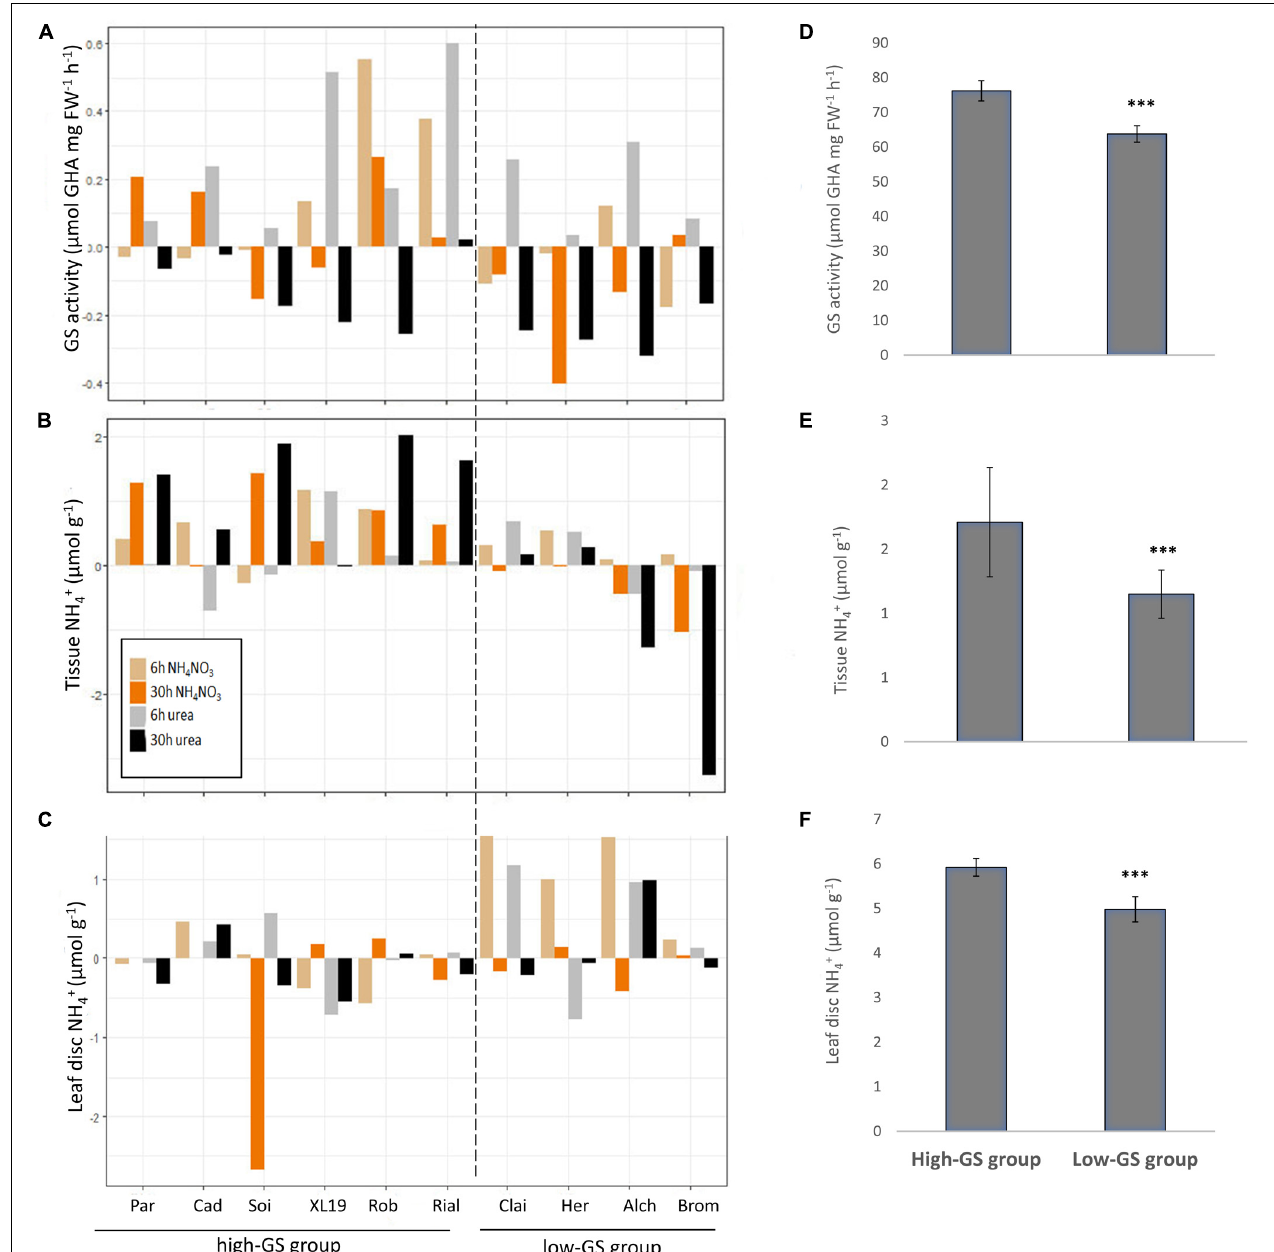
FIGURE 4 | Differential response of ten wheat genotypes to N fertilisers. Ten elite United Kingdom wheat genotypes were treated with the equivalent of 250 kg N ha − 1 applied either as NH 4 NO 3 or urea and the response of GS activity (A) , leaf tissue ammonium (B) and leaf-disc ammonium (C) were measured at 6 and 30 h after N application. The data shown represent log2 transformed relative changes compared to water-treated control plants (average values of six replicates). Data were calculated as LFold_Change = log2(treatment/control_mean). Average values of the actual data for the high-GS and the low-GS group, respectively, are given in (D–F) . Error bars represent standard errors. Differences between groups were significant at p < 0.001. Cad, Cadenza; Par, Paragon; Soi, Soissons; Bro, Brompton; Alc, Alchemy; Her, Hereward; Cl, Claire; XL-19, XL-19; Rob, Robigus; Ria, Rialto. Differences between groups were significant at *** p < 0.001.